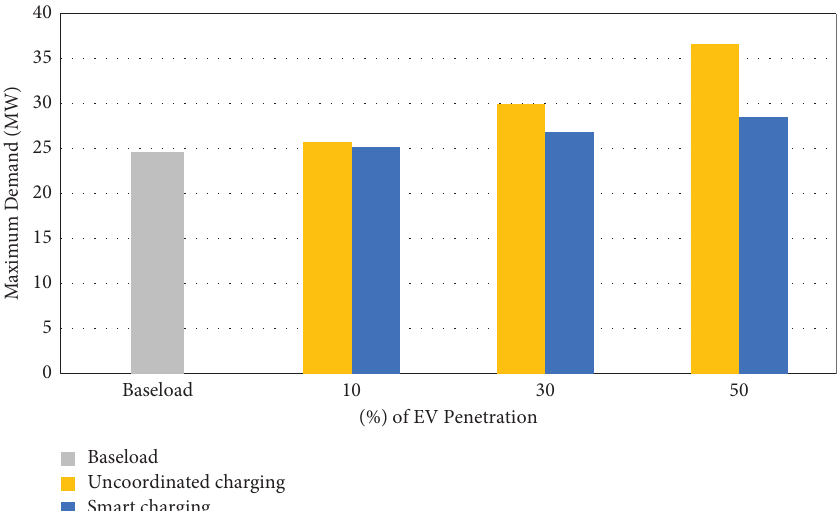
Figure 22: Comparison of peak demands under the three scenarios of EV